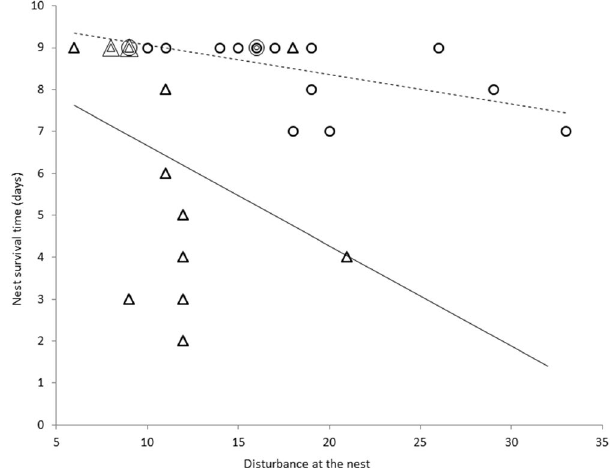
Figure 4. Relationship between the disturbance at the nest and the nest survival time during the poikilothermic nestling stage ( ∆ , n = 14 nests) and the endothermic nestling stage ( ○ , n = 16 nests). Overlapping points are indicated by concentric circles and/or triangles (the number of symbols represents the number of overlapping points). The fit lines serve for visualization purposes, not for statistical inference.